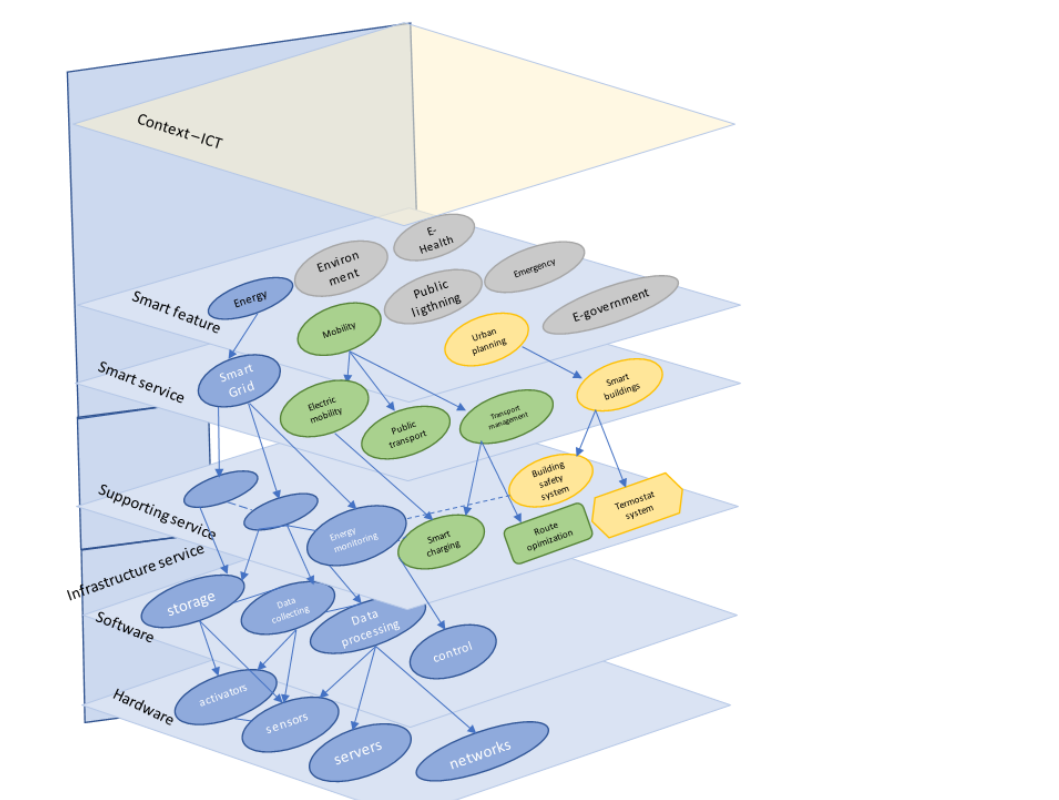
Figure 6. Structure of the smart services in the context of